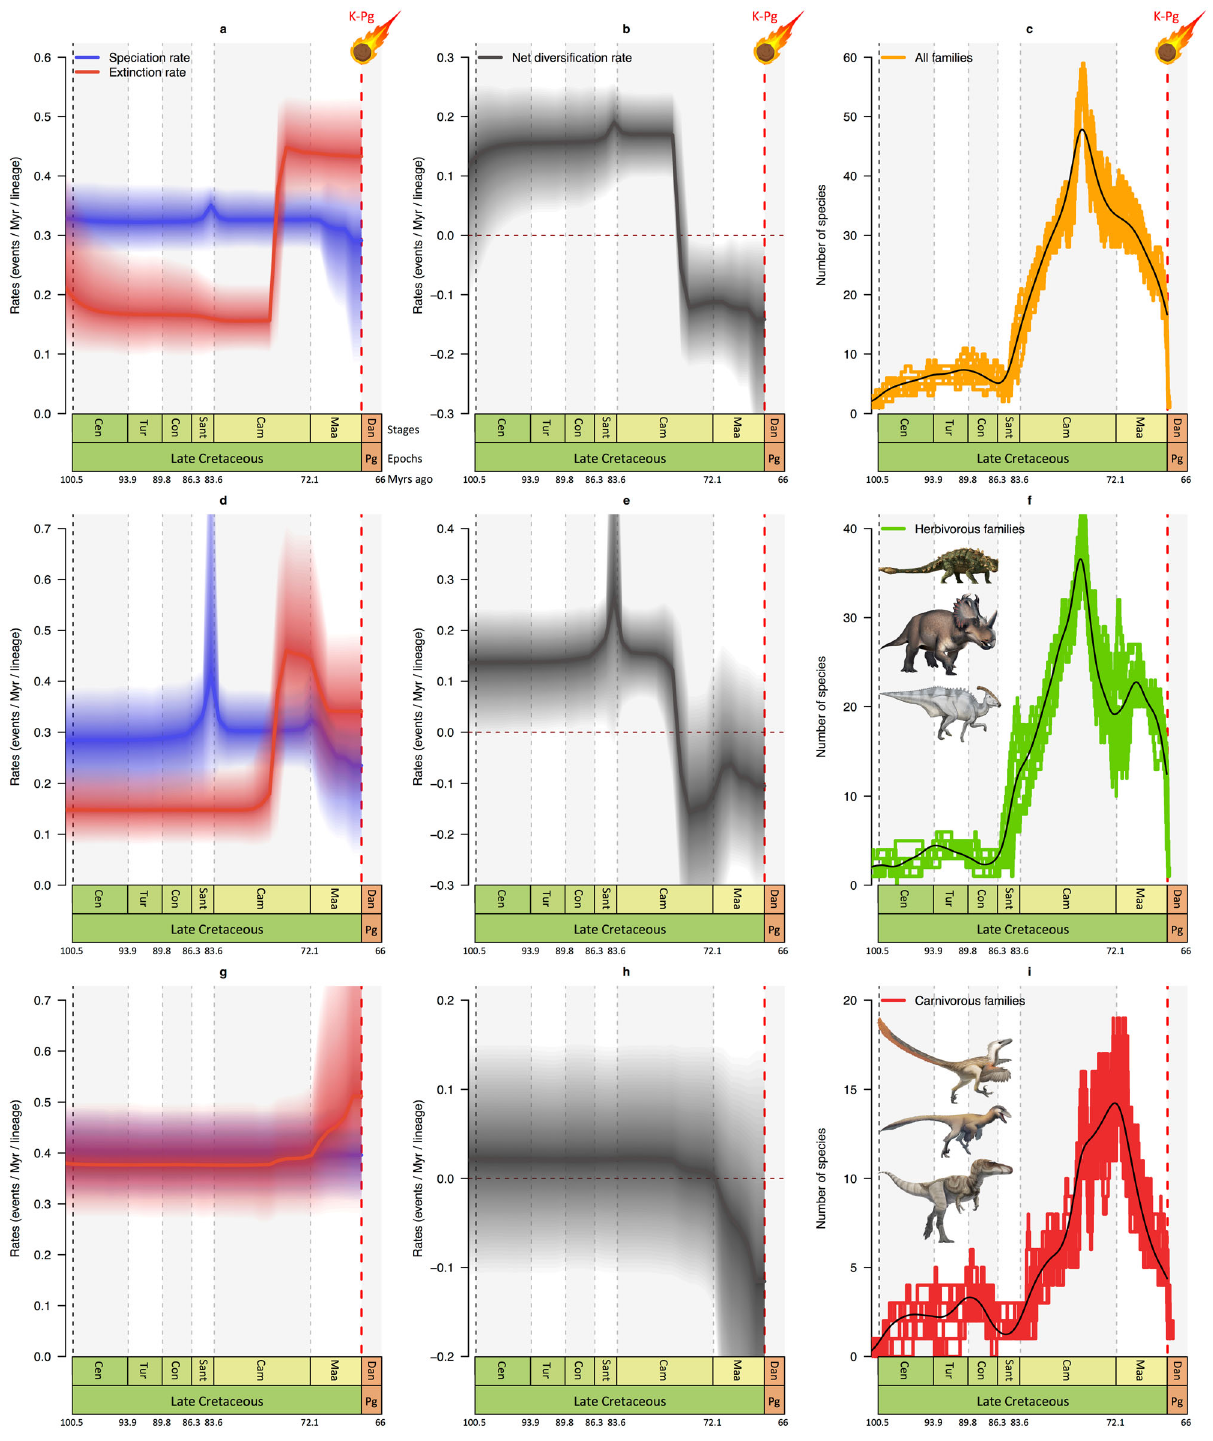
Fig. 1 Diversi fi cation and diversity dynamics of Late Cretaceous dinosaurs. The Bayesian estimates of speciation (blue), extinction (red), net diversi fi cation (black, speciation minus extinction) rates, and diversity of all six non-avian dinosaur families ( a – c ), of the herbivorous families ( d – f ), and of the carnivorous families ( g – i ). Solid lines indicate mean posterior rates and shaded areas show 95% CI. Net diversi fi cation decreased ~83 Myrs ago (mid- Campanian), and became negative ~76 Myrs ago (late Campanian). The diversities (numbers of species) of all dinosaur families, herbivorous families, and carnivorous families were in decline starting in the mid-late Campanian (~76 Myrs ago) or at the Campanian – Maastrichtian transition for carnivores (~72 Myrs ago). Reconstructions of diversity trajectories are replicated to incorporate uncertainties around the age of the fossil occurrences. Apt Aptian, Alb Albian, Cen Cenomanian, Tur Turonian, Con Coniacian, Sant Santonian, Cam Campanian, Maa Maastrichtian, Dan Danian, Pg Paleogene, and K/Pg Cretaceous – Palaeogene mass extinction (66 Myrs ago). Dinosaur pictures courtesy of Fred Wierum (© Wikimedia Commons), Debivort (© Wikimedia Commons), and Jack Mayer Wood (© Wikimedia Commons): https://creativecommons.org/licenses/by-sa/4.0/. Asteroid icon made by Fabien